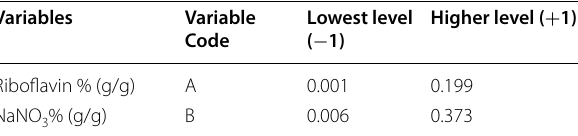
Table 1 Highest and lowest levels ( variables: riboflavin (A) and sodium nitrate (B) used according to the experimental desing for Response Surface Methodology for optimization of protease and conidia production of Metarhizium robertsii ARSEF